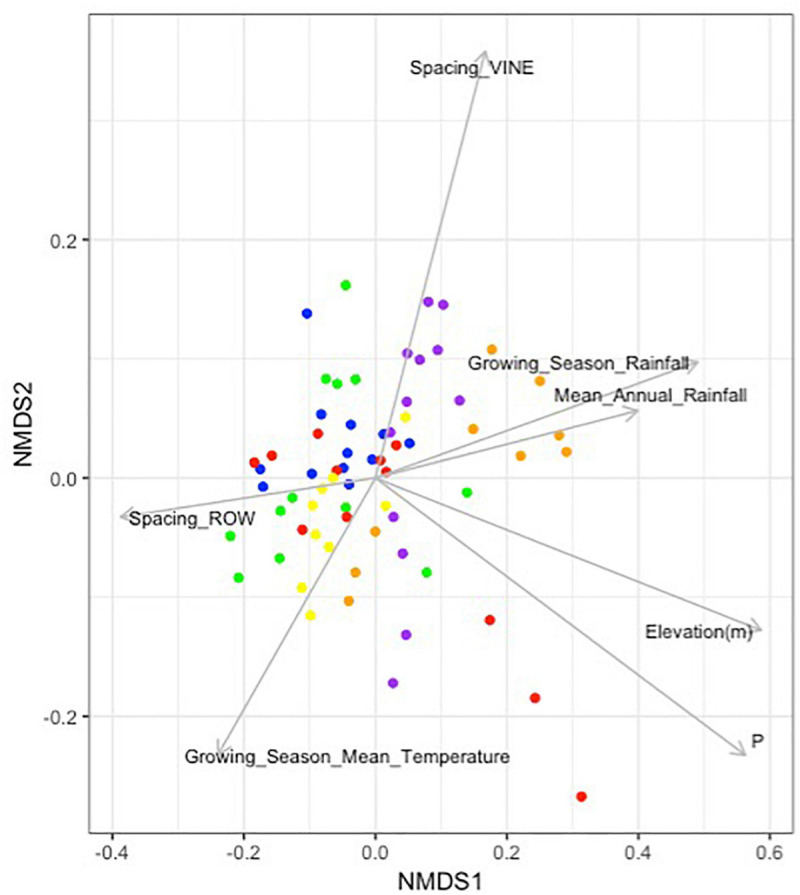
Environmental and vineyard management factors significantly associated with soil microbial community composition in Barossa Region vineyards. Non-metric multidimensional scaling plot displays the microbial community composition of 22 vineyards located in six sub-regions: Northern Grounds (blue); Southern Grounds (yellow); Central Grounds (green); Eastern Edge (red); Western Ridge (purple); Eden Valley (orange). Vector arrows indicate the association with environmental variables with p-value < 0.05. Arrow heads indicate the direction and length indicates the strength of the variable and nMDS correlation. Analysis was conducted using 999 permutations with variables deemed significant where p-value < 0.05.